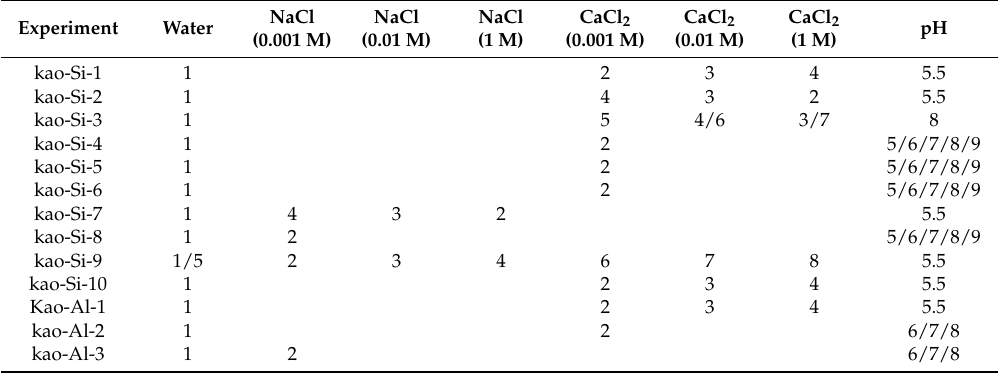
Table 1. Solution composition, order, pH and surface studied for all experiments performed for this study.